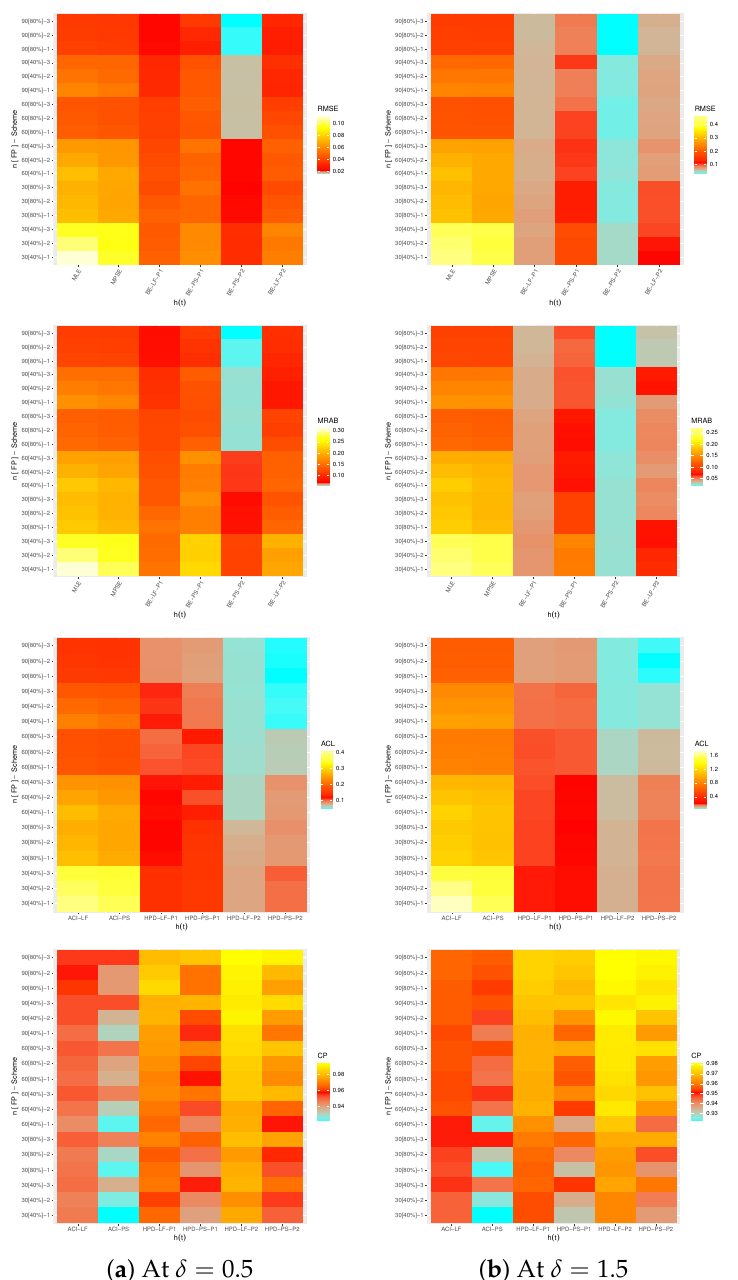
Figure 3. Heatmap plots for the simulation outputs of h ( t )